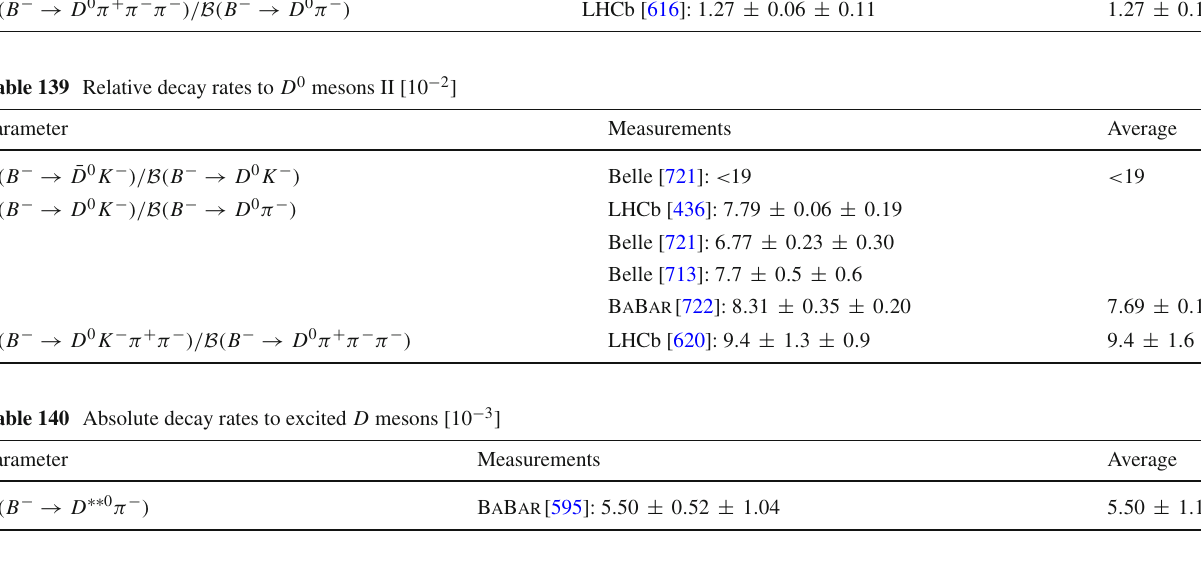
Table 141 Absolute product decay rates to excited D mesons I [ 10 − 3 ] Parameter